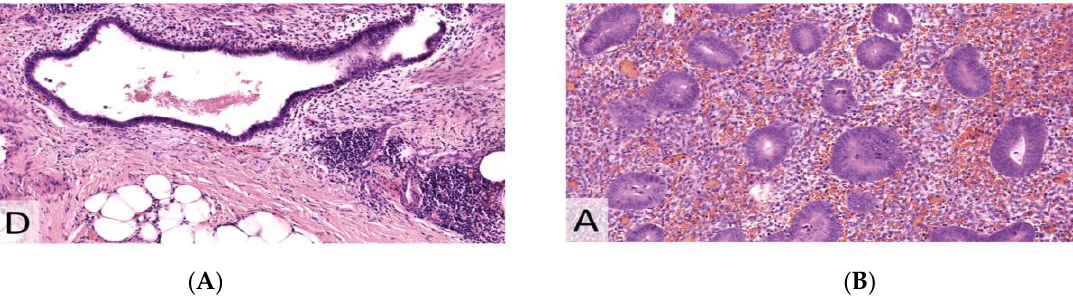
Figure 4. Hematoxylin and eosin (H&E) staining (×200). ( A ) Endometriosis. ( B ) Endometrium.